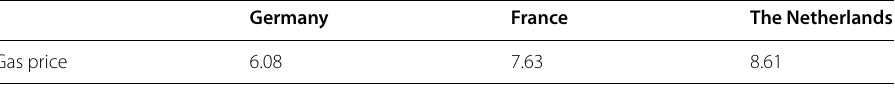
Values are in cent/kWh Table 10 Incentive schemes for prosumers